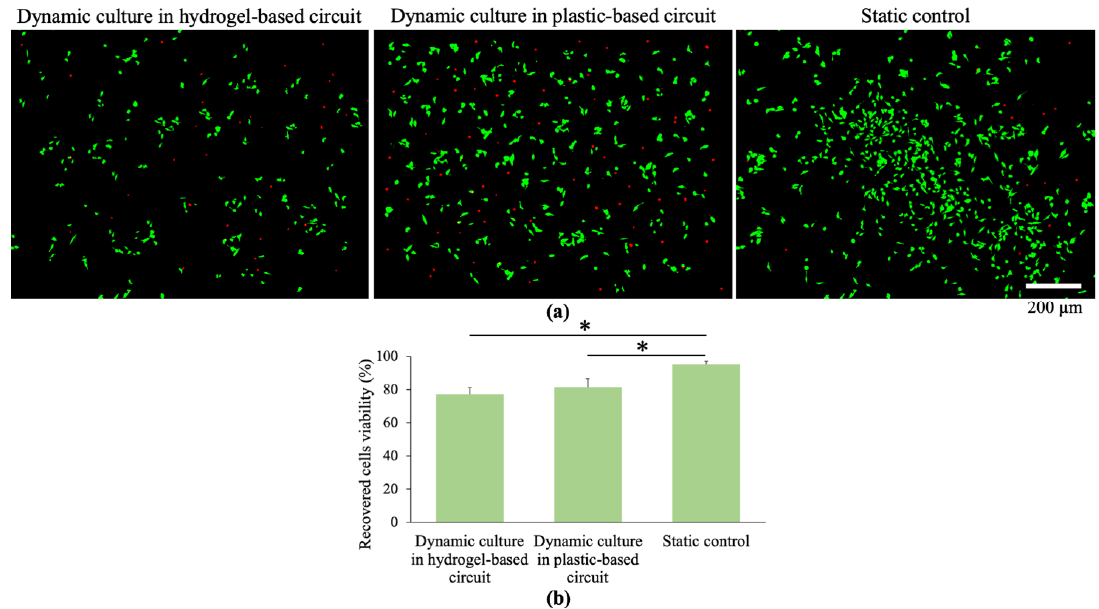
Figure 8. Recovered cells viability measured by live / dead staining of cells after 24 h of circulation within the hydrogel-based circuit (WSS=5 Dyn/cm 2 ), plastic-based circuit (dynamic control, WSS=5 Dyn/cm 2 ) and culture within petri dish (static control) ( a ); quantitative analysis of the images, values are reported as mean ± s.d., N = 3, student’s t-test: * p < 0.05 ( b ).